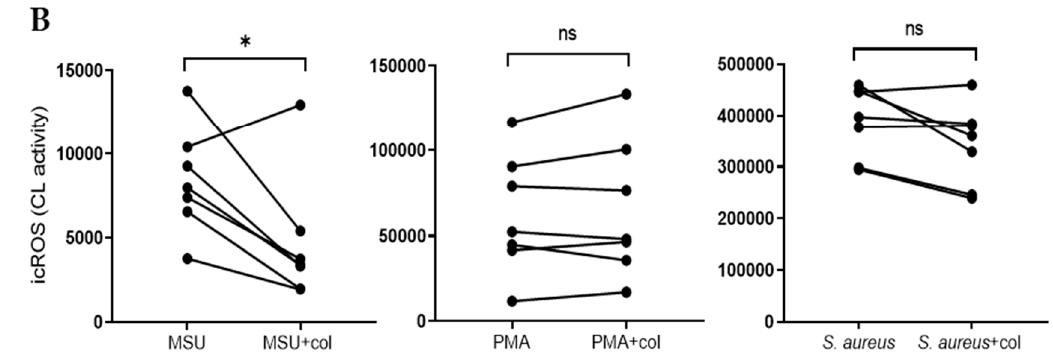
Figure 3. MSU triggered intracellular ROS is inhibited by cytochalasin B (CytB) and colchicine (col). ( A ) Neutrophils were pretreated with cytochalsin B (5 µ g / mL), an inhibitor of actin polymerization, and stimulated with either MSU crystals (300 µ g / mL), PMA (50 nM) or opsonized S. aureus and intracellular ROS production (icROS) was evaluated using luminol amplified CL. Cytochalasin B-treated cells produced lower amounts of icROS in response to MSU crystals and S. aureus as compared to untreated cells, while icROS production in response to PMA was not a ff ected by the presence of cytochalasin B. Peak CL values are shown. ( B ) Neutrophils were pretreated with colchicine (1 µ g / mL) and stimulated with either MSU crystals (300 µ g / mL), PMA (50 nM) or opsonized S. aureus and icROS production was evaluated using luminol amplified CL. Colchicine decreased icROS in response to MSU crystals, while icROS production in response to PMA or S. aureus was not a ff ected. Peak CL values are shown ( n = 7). * p ≤ 0.05 and ** p ≤ 0.01. ns = not significant.